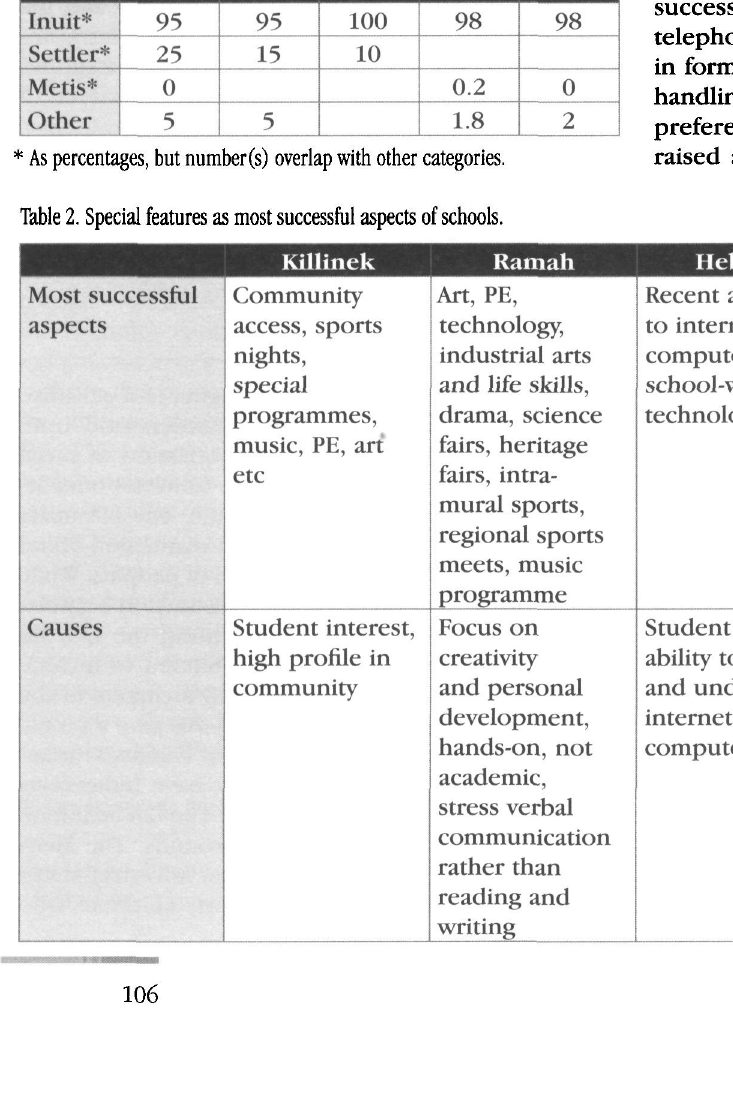
Table 2. Special features as most successful aspects of